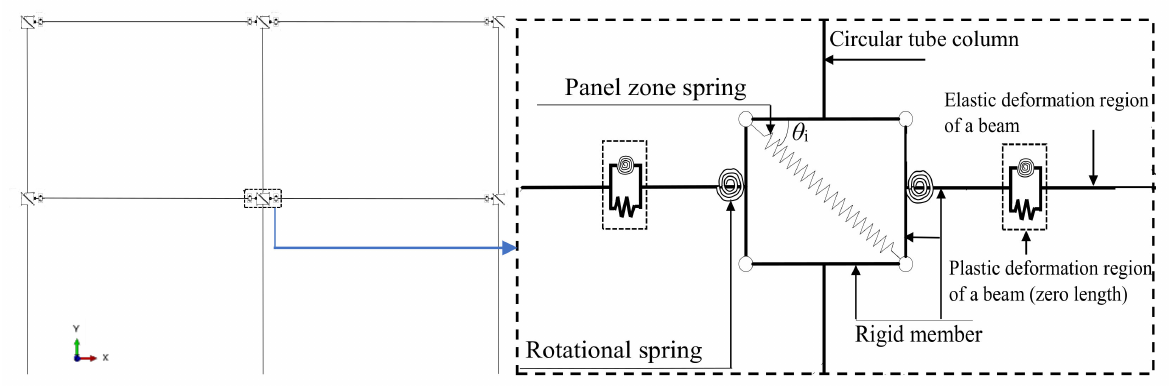
Figure 14. Component-based model of the frame with circular tube columns and CSS